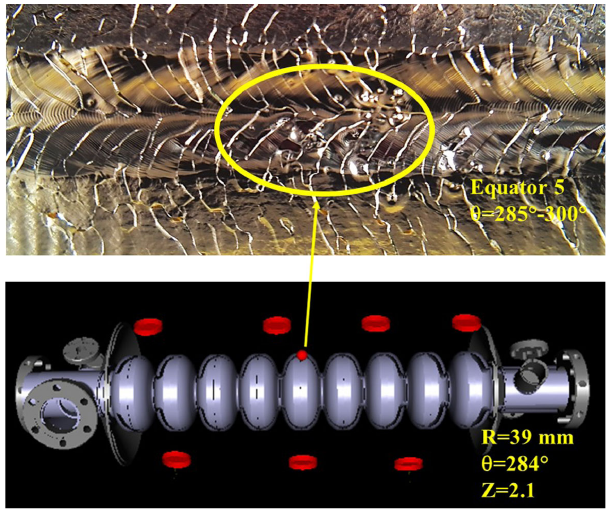
FIG. 6. Second sound quench reconstruction for cavity 3HZ014 (below) at 1.8 K and optical image of the quench position (top).